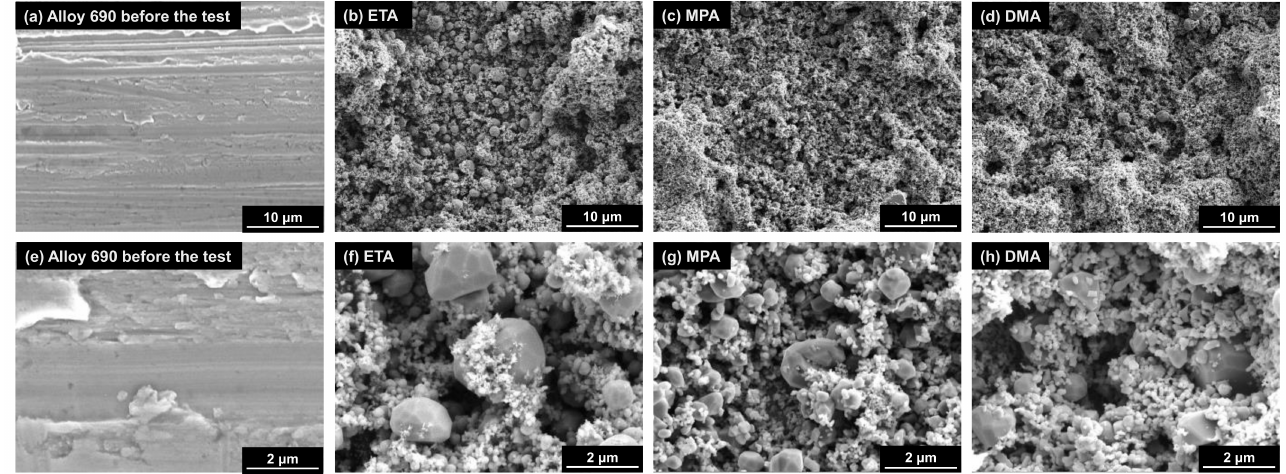
Figure 5. SEM images of surface morphologies of simulated deposits on Alloy 690TT tubes using three advanced amines: low magnification ( a ) Alloy 690 before the test, ( b ) ETA, ( c ) MPA, and ( d ) DMA and high magnification ( e ) Alloy 690 before the test, ( f ) ETA, ( g ) MPA, and ( h ) DMA.